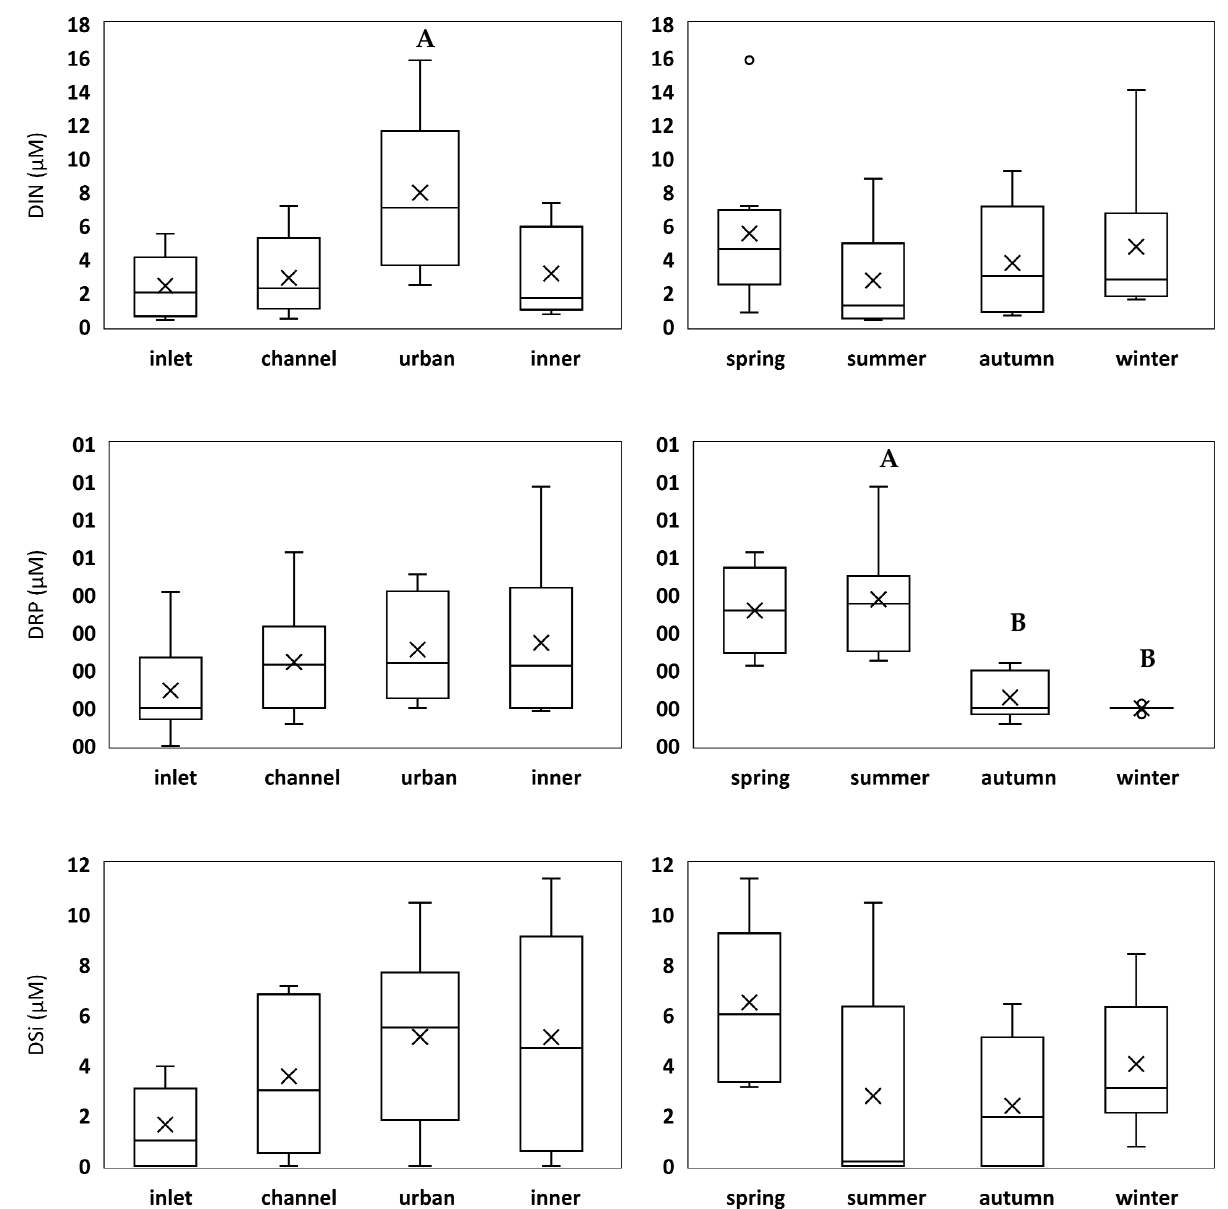
Figure 1. Box − whisker plots showing the median (horizontal line inside the box), mean (cross), interquartile ranges (25th and 75th; boxes), minimum and maximum values (whiskers), and outliers (open circles) for several environmental variables, across sampling locations (left column) and seasons (right column). Significant differences are indicated with letters (A, B) above the respective bar.